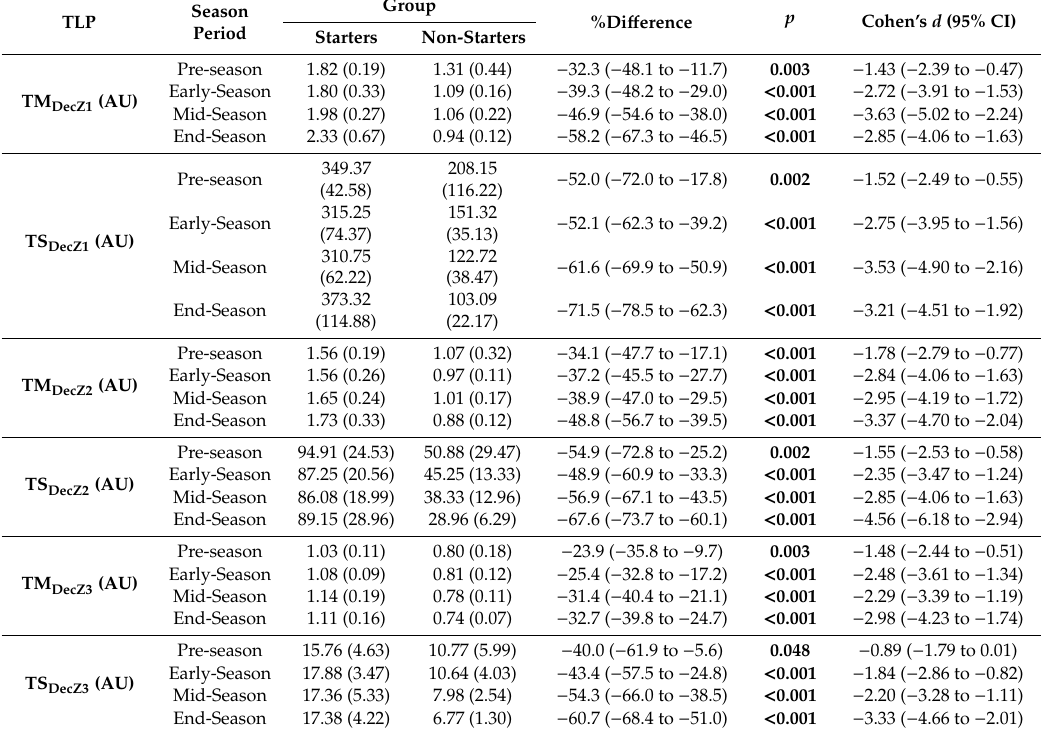
Table 3. Di ff erences between starters and non-starters in terms of training monotony and training strain based on deceleration-derived GPS variables in the full-season and its di ff erent periods. Group Season TLP %Di ff erence p Cohen’s d (95% CI) Period